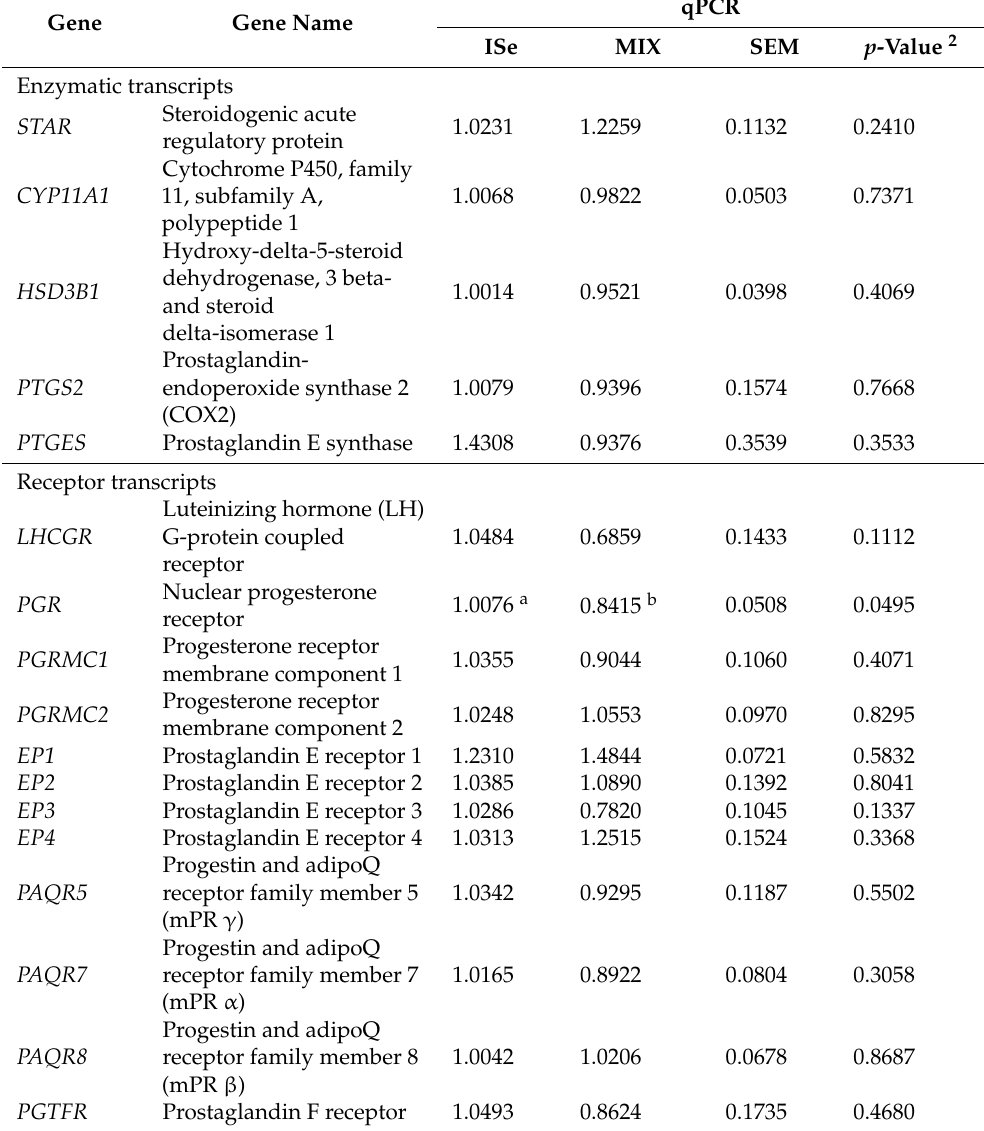
Table 3. Effect of form of Se on the relative expression of mRNA transcripts encoding steroidogenic enzymes and receptors in the Day 7 CL. Cows were supplemented with Se as sodium selenite (ISe, n = 5) or a 1:1 equimolar mix of ISe and OSe (MIX, SEL-PLEX, n = 5) 1,†